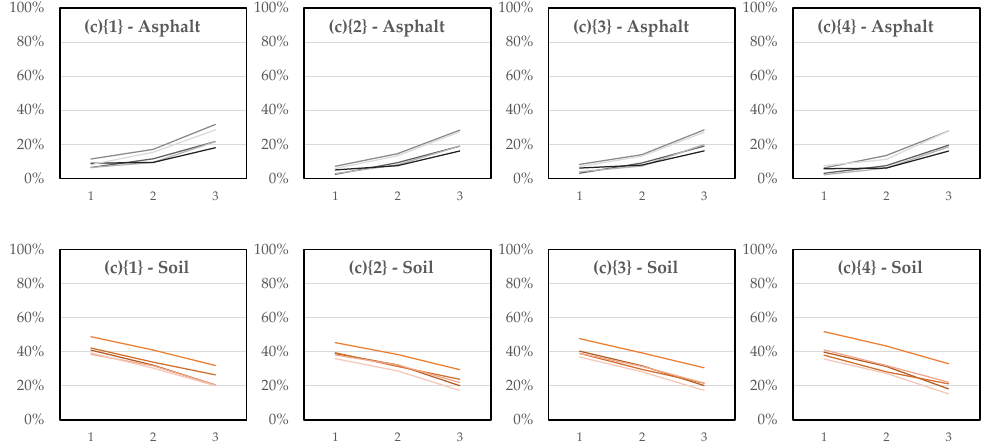
Figure 4. Spectral signatures of 15 control points manually captured from radiometrically calibrated rasters. The points are distributed among five points in vegetated areas, five in asphalt areas, and five in bare ground areas. The results are shown in scenarios ( a ), ( b ) and ( c ) in spatial resolutions {1}, {2}, {3} and {4}. In abscissa the band number, inordinate the percentage reflectance value recorded.